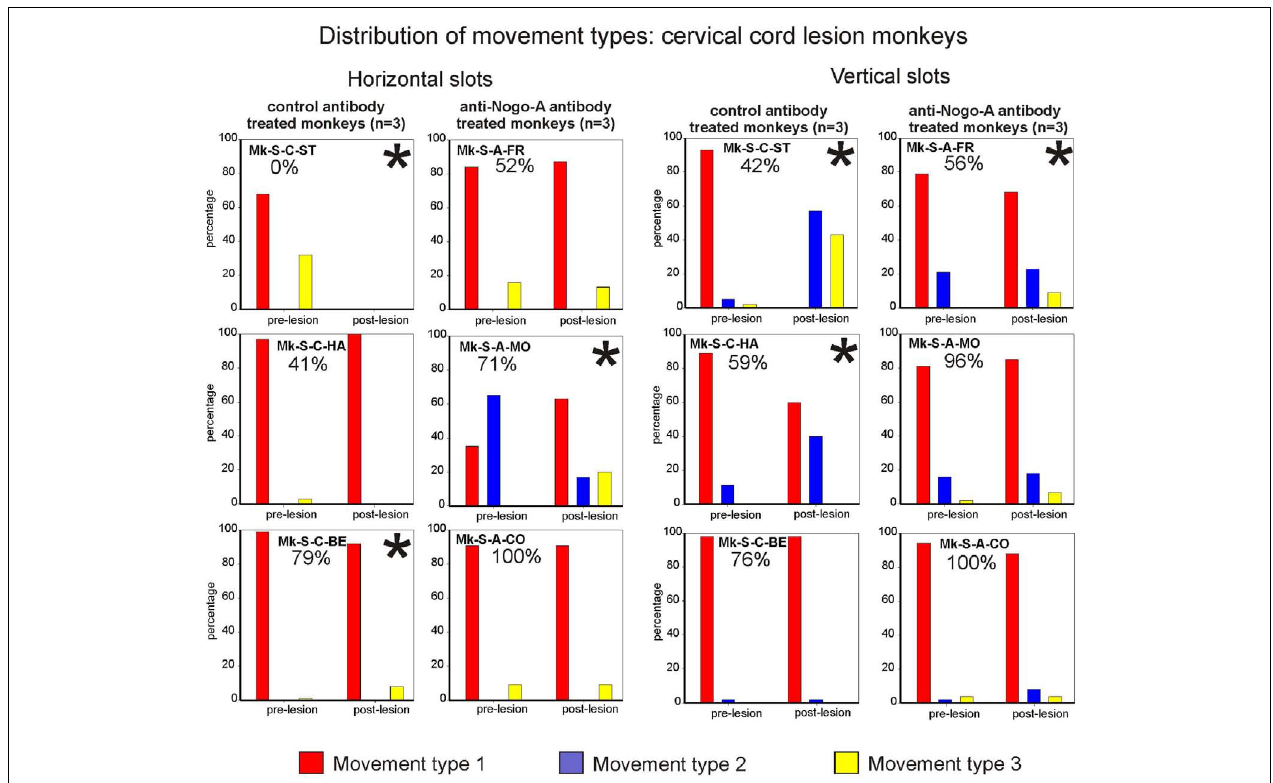
the task between the pre- versus post-lesion periods (chi-square test, p < 0.05). For Mk-S-C-ST, it has been considered that there was a significant change in movement patterns as this monkey was unable to execute the task after the